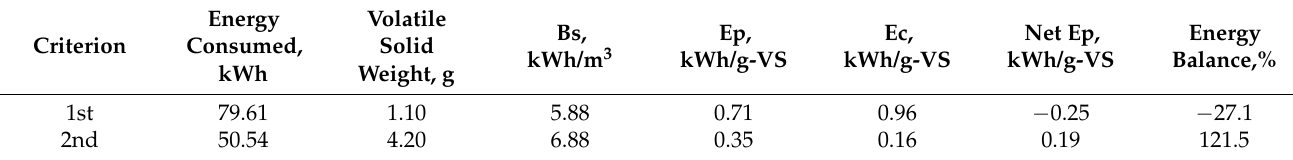
Figure 46. The second criterion overlay figure for extracted oil date seed. Table 18. Energy evaluation of optimisation criterion for date